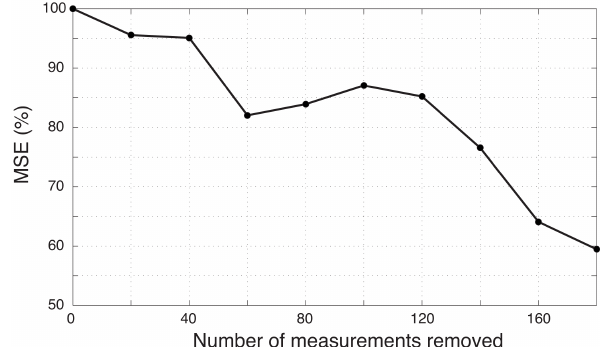
Figure 1. Histogram of the additive error e . For clarity, the zero- error bin has been omitted here.